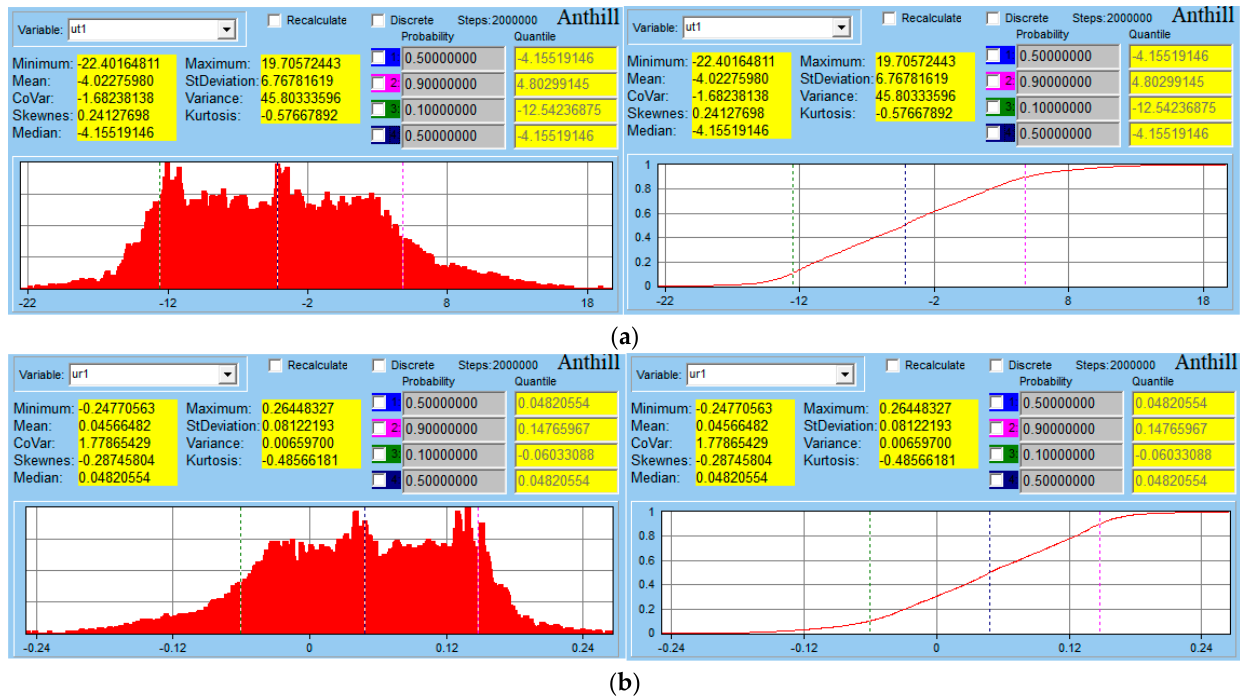
Figure 13. Histograms and distribution functions for node ‘1’ ( a ) tangential components of crustal surface displacement, ( b ) radial components of crustal surface displacement (sw MSC.Marc Mentat and Anthill).